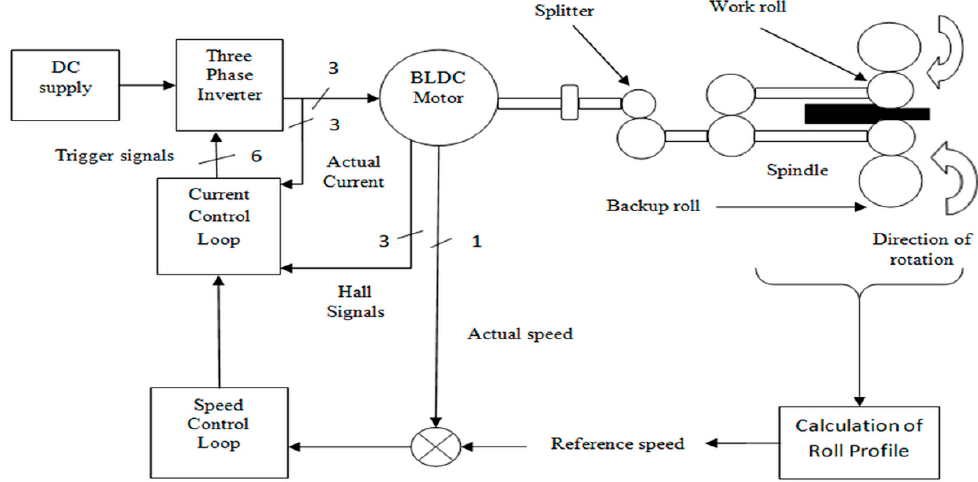
Figure 1. Direct current (DC) motor drive system coupled to a hot rough rolling mill.